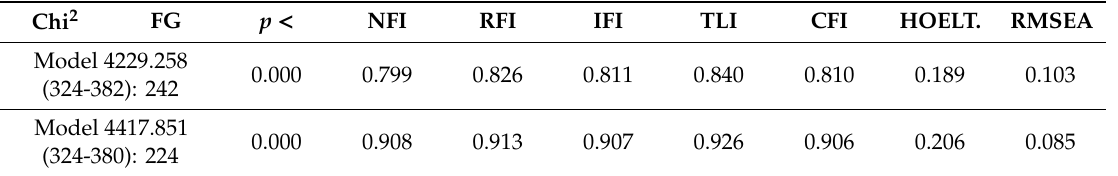
Table 3. Models of structural linear results of the